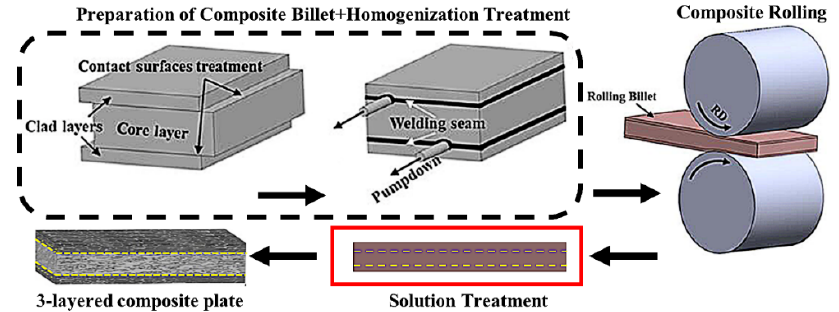
Figure 4. The schematic diagram showing the preparation of B steel composite plate [26].